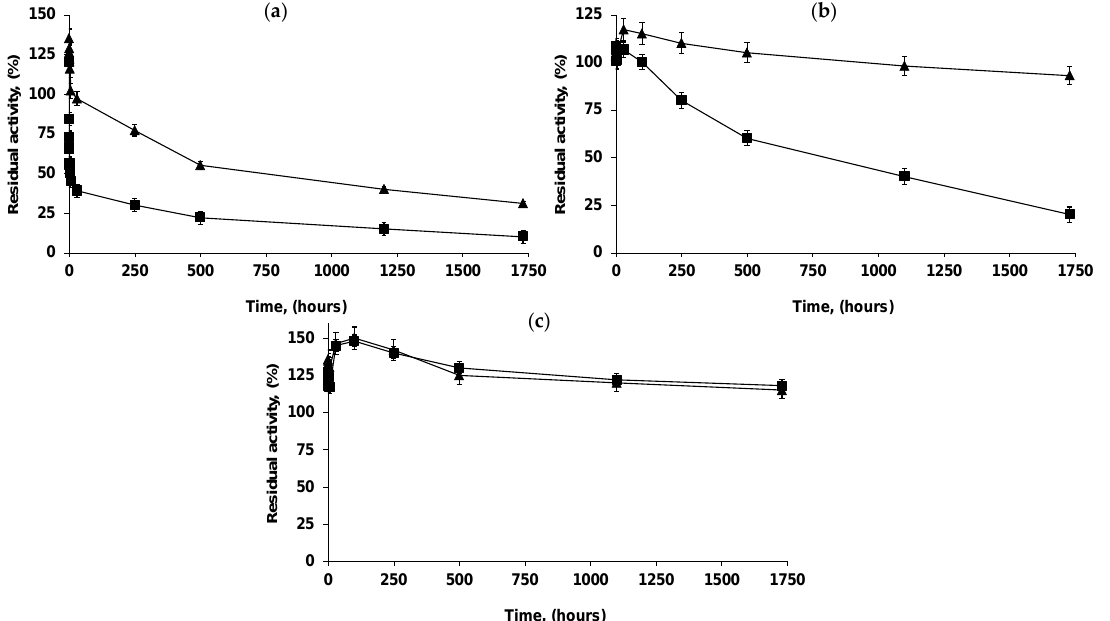
Figure 6. Inactivation courses of different immobilized lipases in the presence of 90% ( v/v ) organic co-solvents at pH 7.0 and 25 °C. ( a ) Methanol, ( b ) dioxane, or ( c ) acetonitrile. The aqueous phase was 100 mM Tris. Other specifications are described in the Methods section. Filled squares: TLL-octyl and filled triangles: ET-octyl.